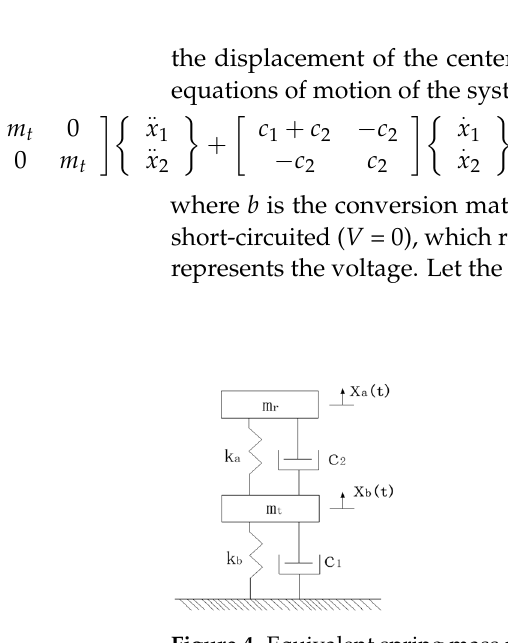
Figure 4. Equivalent spring mass model.